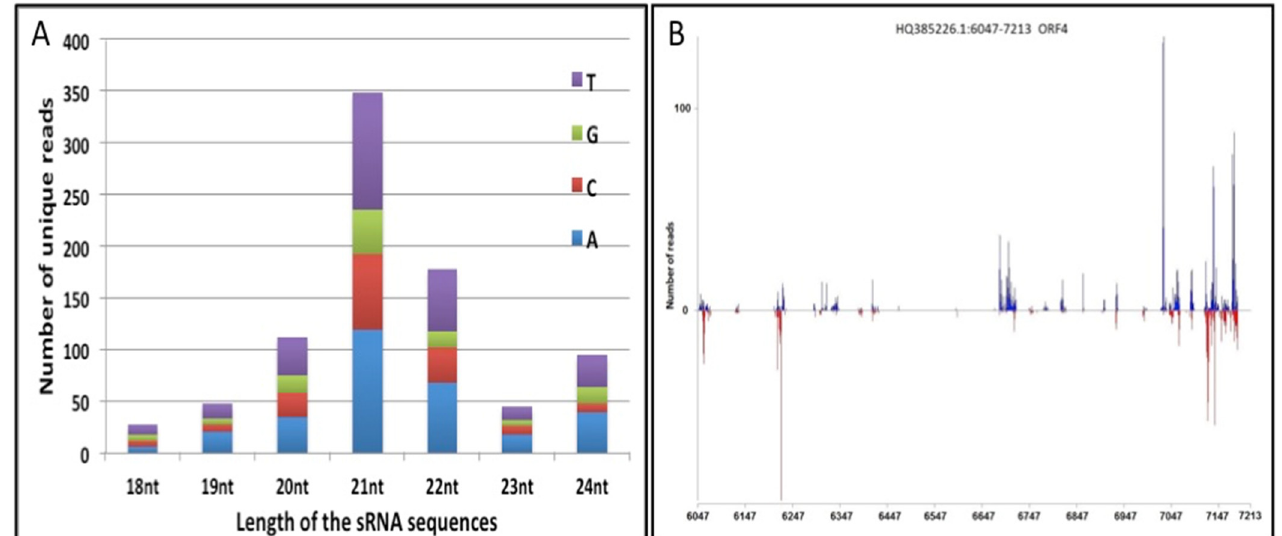
Figure 1. Size distribution and mapping of small RNA reads obtained from tungro infected data sets: ( A ) Length distribution of the small RNA sequences showing the distribution of the first nucleotide in the molecules. ( B ) Plot of siRNA molecules mapping of ORF-IV for RTBV. The nucleotide position of ORF is shown on the X-axis. siRNAs mapping to the positive strand of the ORF are represented by blue lines, while those mapping to the negative strand are represented by red lines.